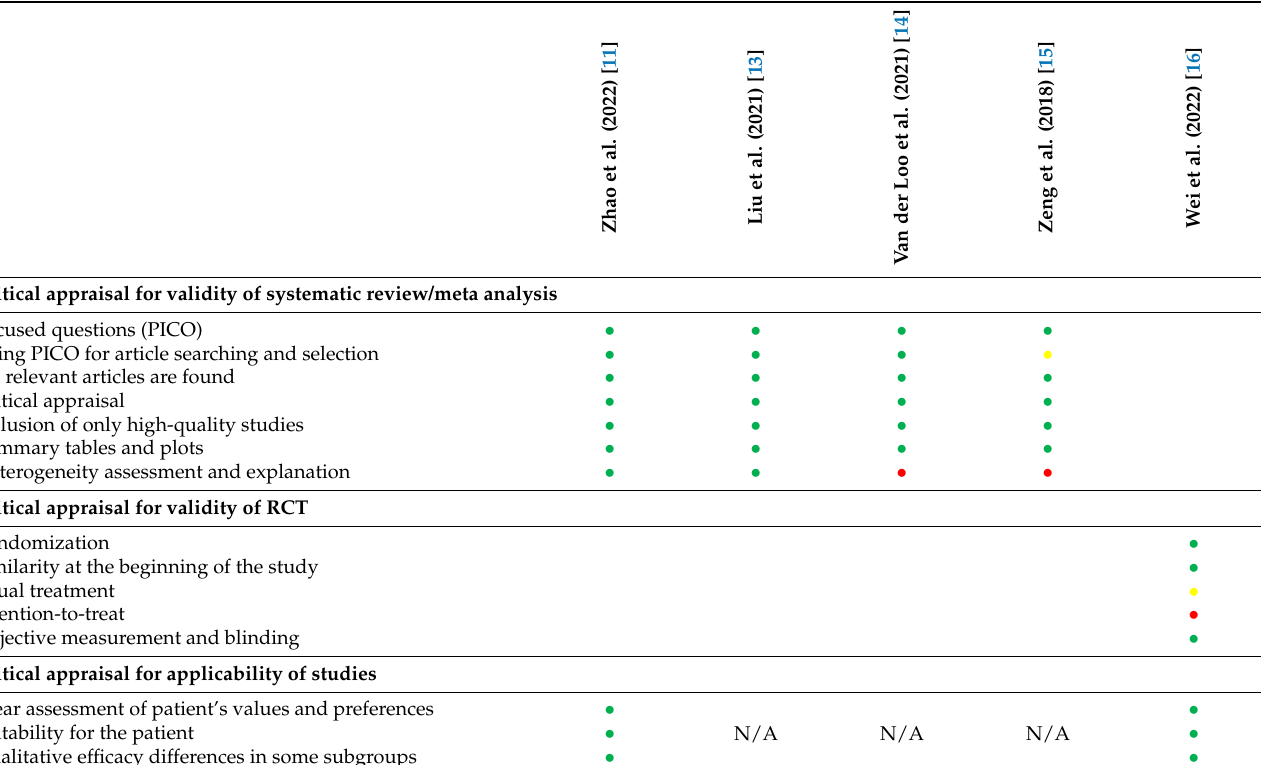
Table 2. Critical appraisal for validity and applicability of studies included.